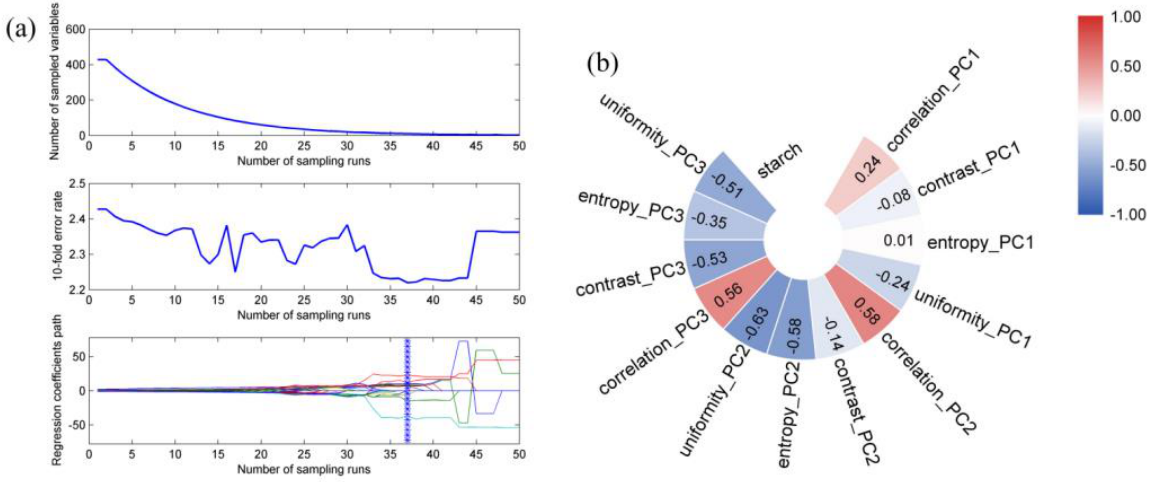
Figure 3. ( a ) Results of CARS method for wavelength selection; ( b ) correlation plot between textural variables and measured starch content.